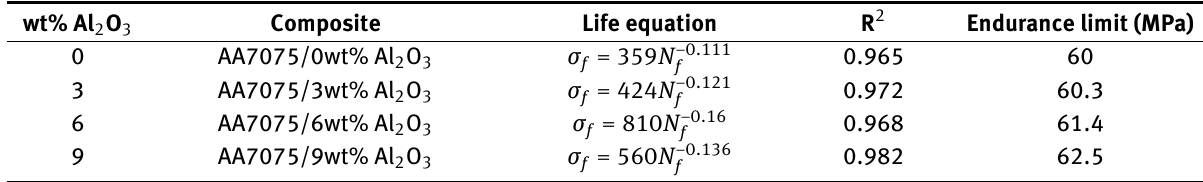
Table 5: The endurance limits with (life)